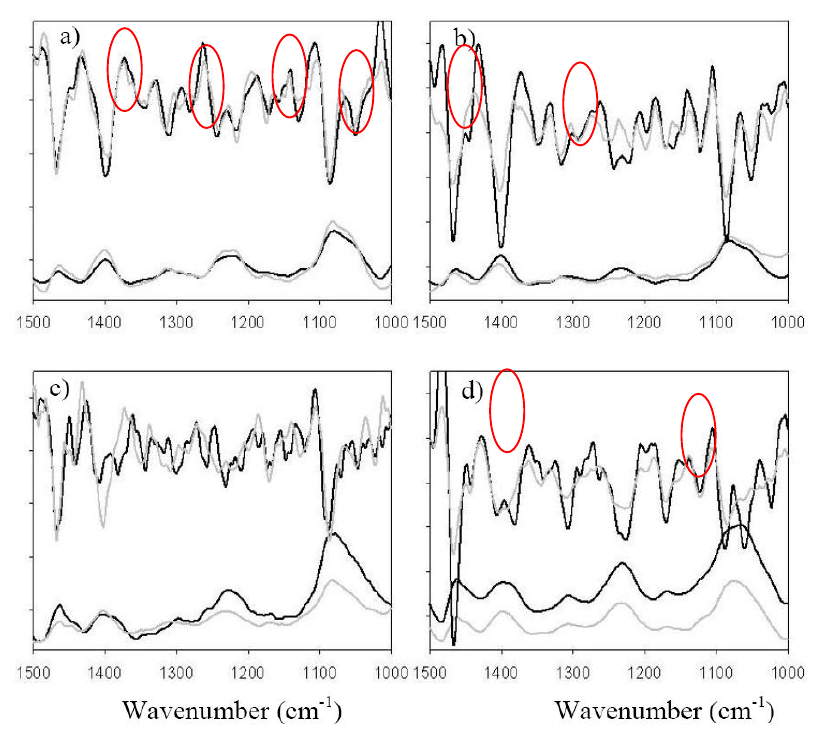
Figure 3. IR spectra and second derivative of the four brain samples analyzed. Black spectra and derivatives correspond to the left (normal) hemisphere. Grey spectra and derivatives correspond to the right (ischemic) hemisphere. The circles denote the relevant spectral areas as explained in the